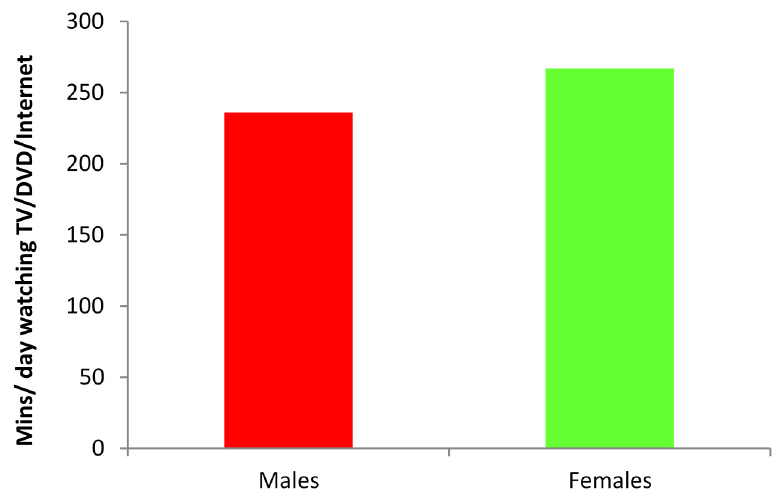
Figure 5. Combined time per day spent on computer/Internet, TV/DVD/video